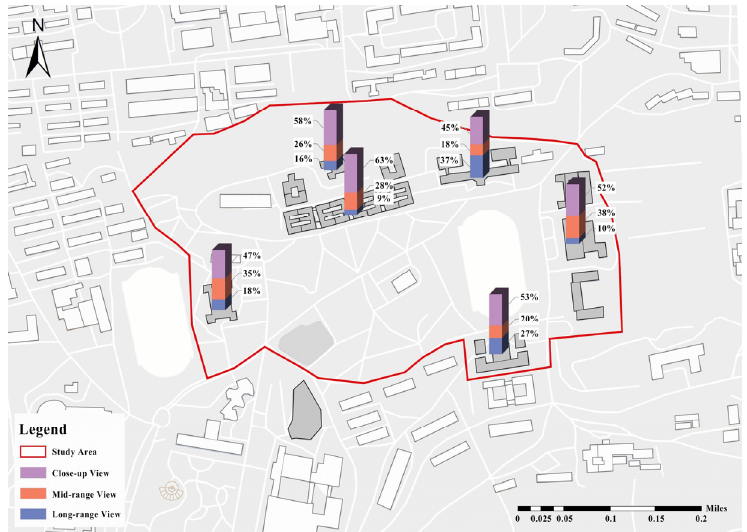
Figure 5. Analysis of landscape visual scale.